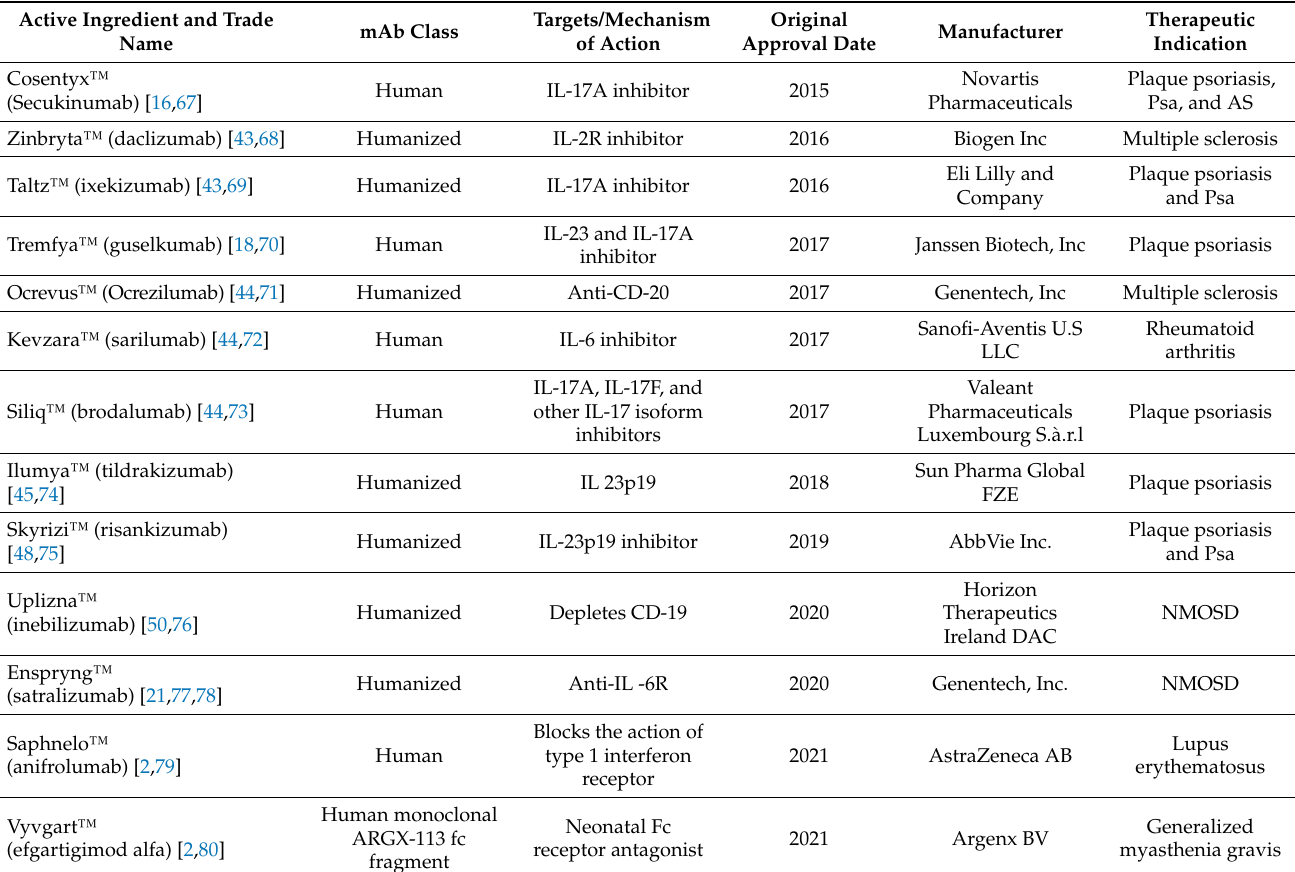
Table 6. Biopharmaceuticals for autoimmune diseases approved by the Food and Drug Administra- tion from 2015 to